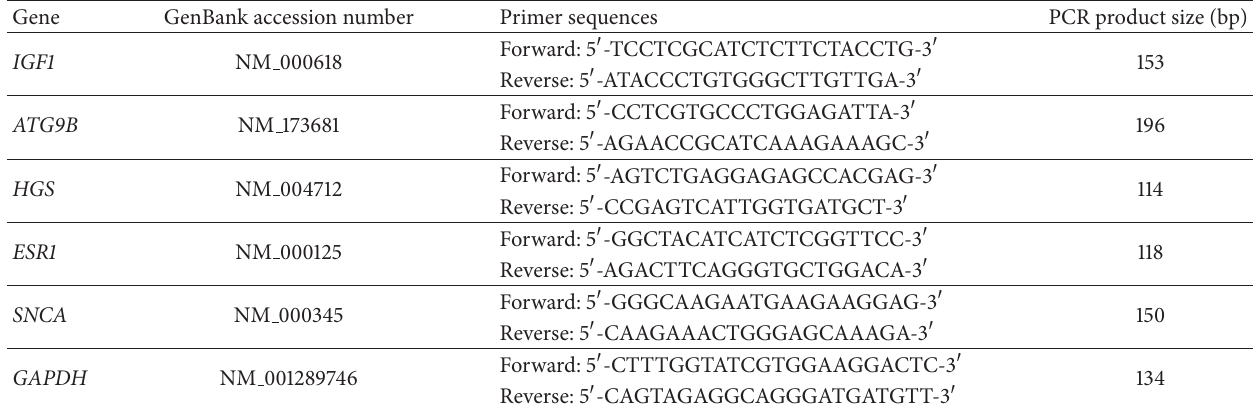
Table 2: Primer pairs designed for quantitative real-time RT-PCR